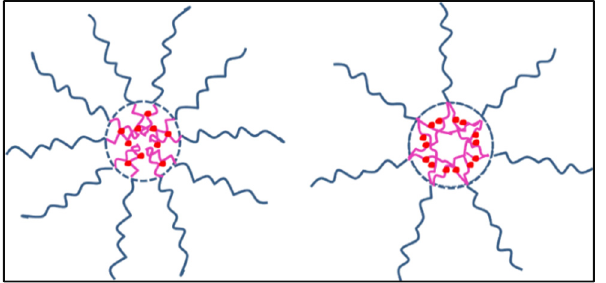
Figure 8. Linear (left) and Y-shaped DOX loaded copolymers (right) Adapted from [92]. MDPI, 2014.